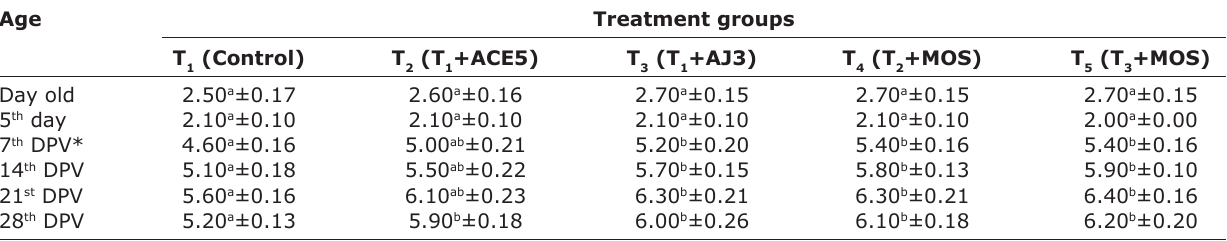
Table-1: Humoral immune response (log value of HI titer) to NDV in broiler chickens under different dietary treatments. 2 Age Treatment